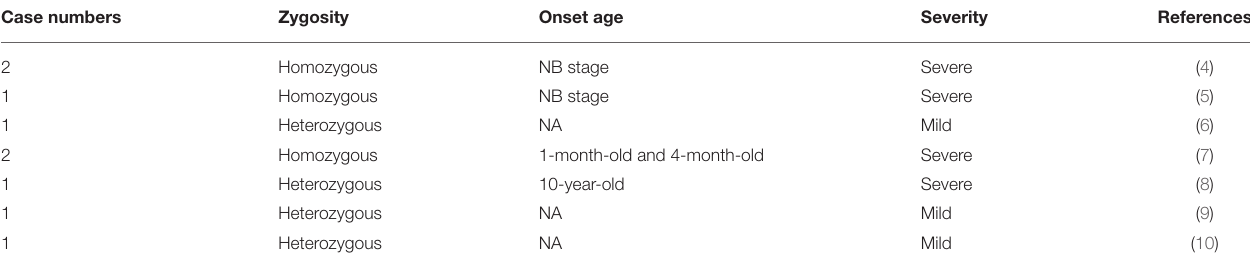
TABLE 2 | Cases with FVII:c 681 + 1 G > T (IVS6 + 1G > T) mutation collected in